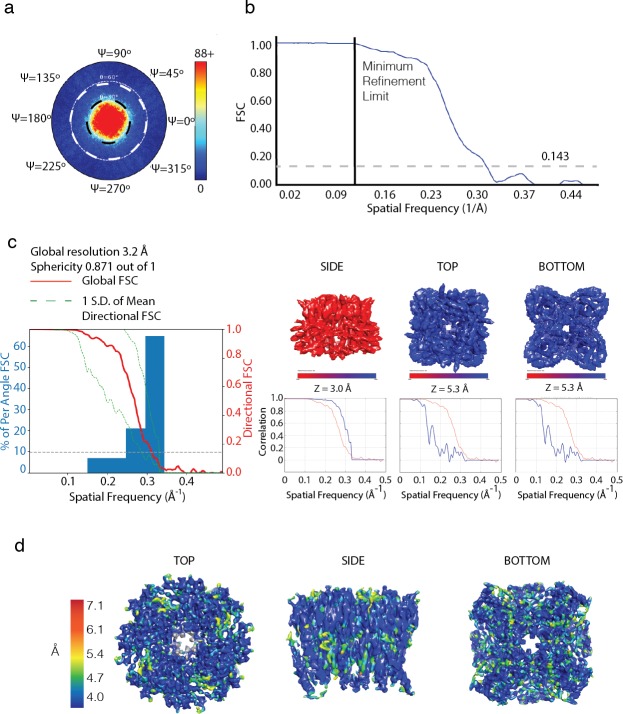
2D and 3D Fourier Shell Correlation (FSC) curve analysis and local resolution map of polycystin 2-l1.(a) Angular distribution plot, inner black dashed ring (θ = 30°) and outer white dashed ring (θ = 60). (b) Corresponding 2D FSC of polycystin 2-l1 in PMAL C8 (horizontal dashed 0.143 criterion; solid vertical black line is the minimum refinement limit of 8 Å. (c) 3D FSC and preferred orientation analysis of the same dataset with the red line representing the estimated global FSC of 3.2 Å ± 1 SD (green dashed lines). Dashed line 0.143 criterion are at left and the correlated resolution estimations and orientations from the preferred orientation analysis are at the right. Red lines represent global estimated FSC, black lines FSC for the z-axis of the orientation indicated above. Color code (red (poorer) to blue (better) resolution) represents in-plane resolution (x/y axes) and resolution value Z (including graph below) refers to the z-axis directional resolution and corresponding FSC plot. For instance, the side view shows an increased z-axis resolution but a decreased x/y resolution (red) which is consistent with the angular distribution plot. (d) Local resolution map (calculated by ResMAP with a value of box 20 and cutoff 0.5) of the same dataset with top, side, and bottom orientations.